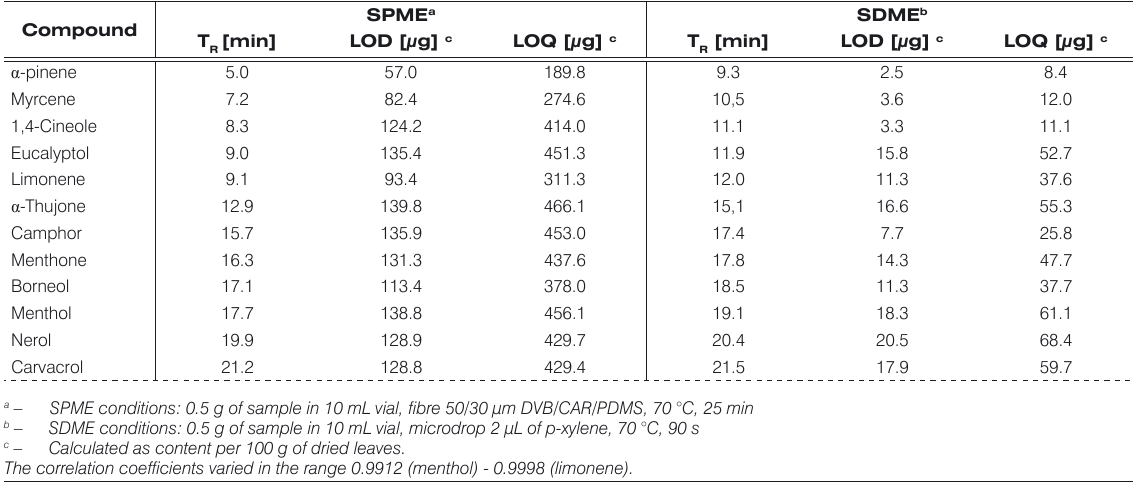
) together with the LOD and LOQ values for both microextraction methods. R SPME a